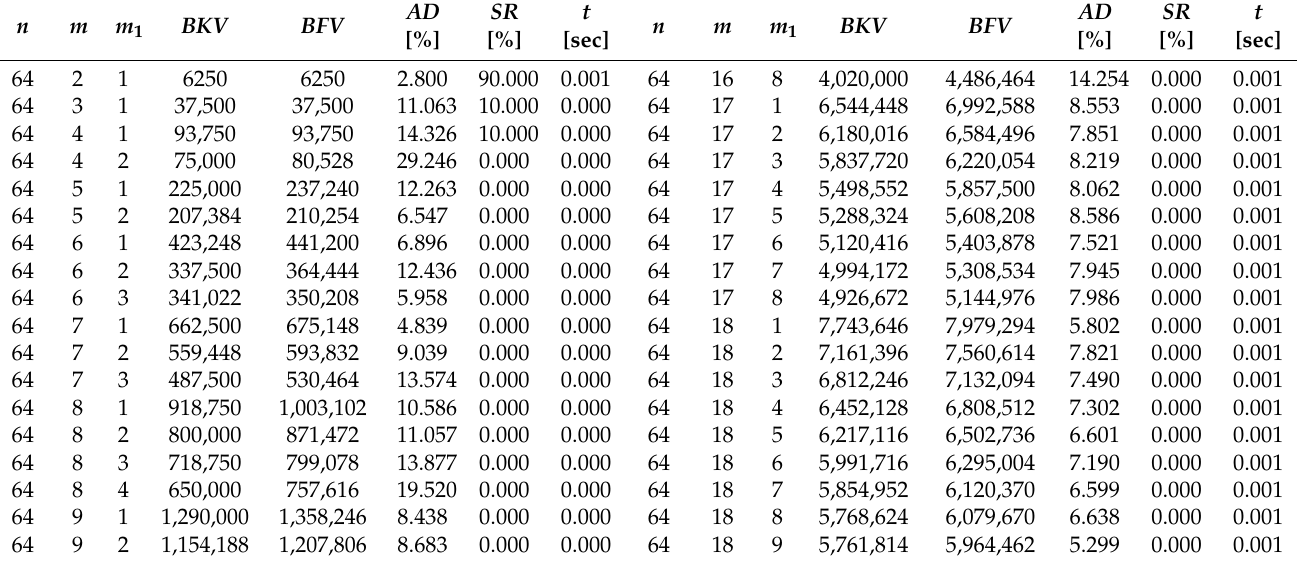
Table 3. Results of the computational experiments (part